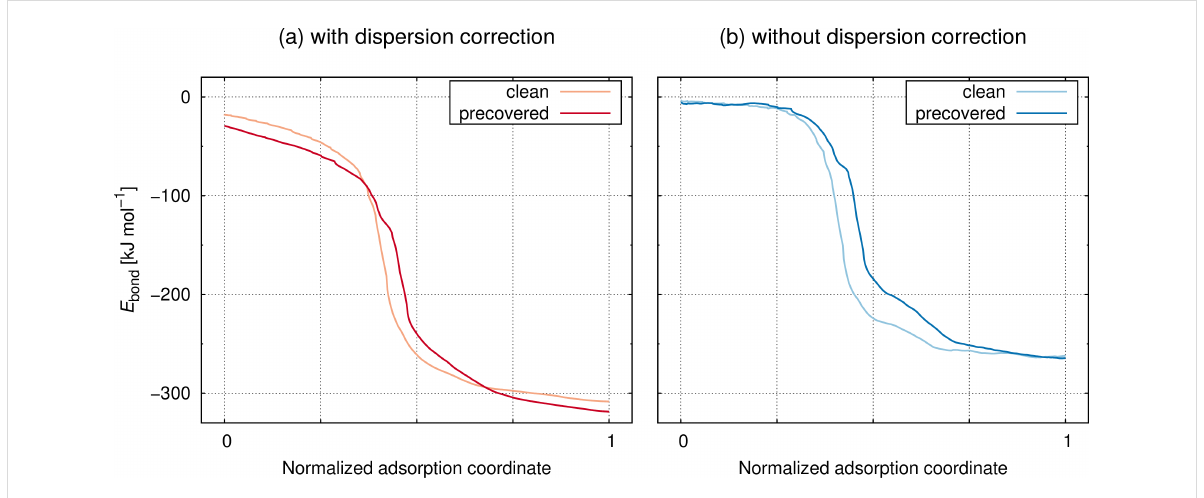
Figure 3: Energy profile of the adsorption pathway depicted in Scheme 1 on the clean and precovered Si(001) surface computed with (a) PBE-D3 and (b) PBE.